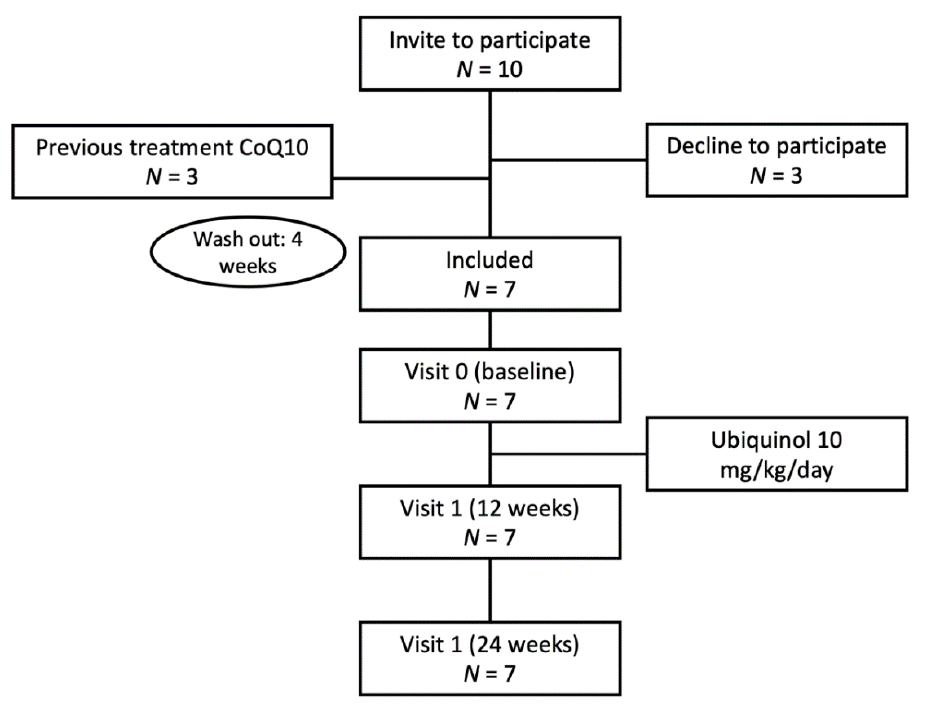
Figure 2. Study flow chart.